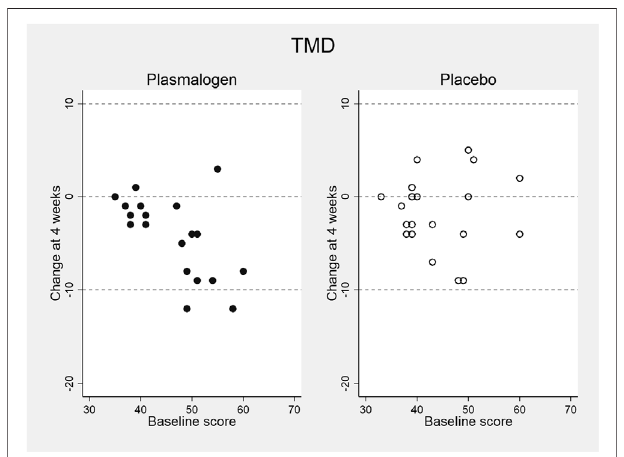
FIGURE 2 | Changes in anger-hostility (AH) and fatigue-inertia (FI) T-scores of POMS 2 at 4 weeks versus baseline scores in plasmalogen and placebo groups. Points of identical values in the two dimensions are minimally shifted along the vertical direction and are displayed as aggregated circles.